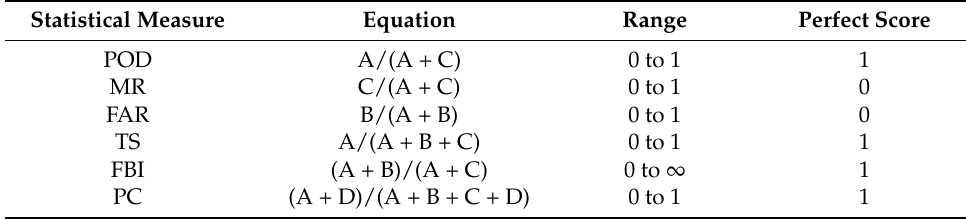
Table 4. Statistical measures obtained by a contingency